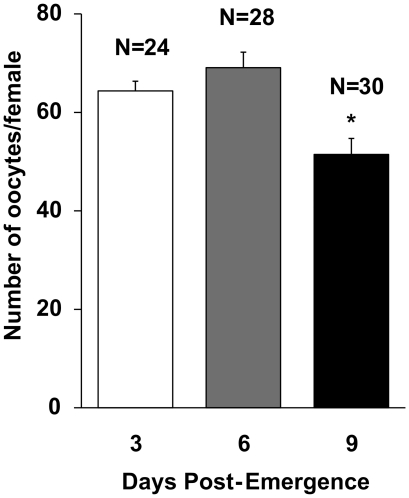
Effect of age at blood feed on subsequent fecundity of female Lu. longipalpis.Bars represents average number of oocytes dissected 5 days after blood meal ± SEM. Sand flies were blood-fed at 3, 6 and 9 days Post-Emergence. Asterisk indicates statistical difference at P<0.005 (ANOVA). Results represent two independent biological replicates.